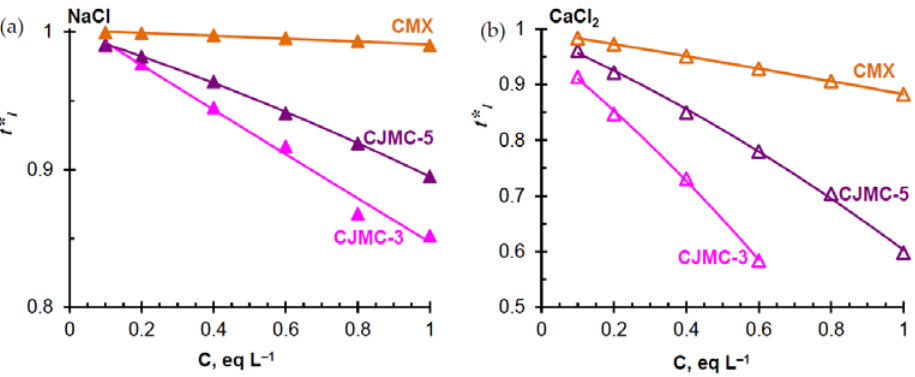
Figure 6. The counterion transport numbers in the studied cation-exchange membranes vs. concentration of NaCl ( a ) and CaCl 2 ( b ) solutions. The lines are drawn to guide the